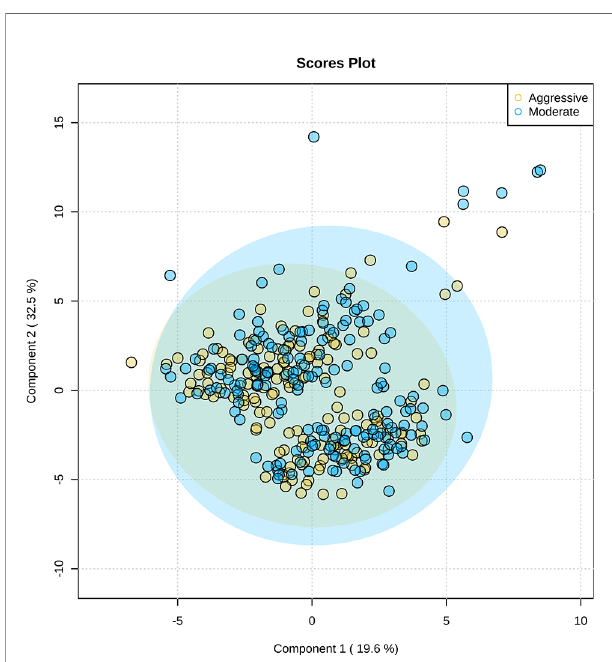
FIGURE 11 | Partial least-squares discriminant analysis of 115 rumen fl uid metabolites identi fi ed through untargeted metabolomics. The aggressive implant strategy is represented in yellow and the moderate implant strategy is represented in blue. Signi fi cant overlap of metabolites present in moderate and aggressive implant strategies illustrates similarity of rumen fl uid metabolic pro fi les. Shaded regions represent a 95% con fi dence interval around the metabolites per treatment